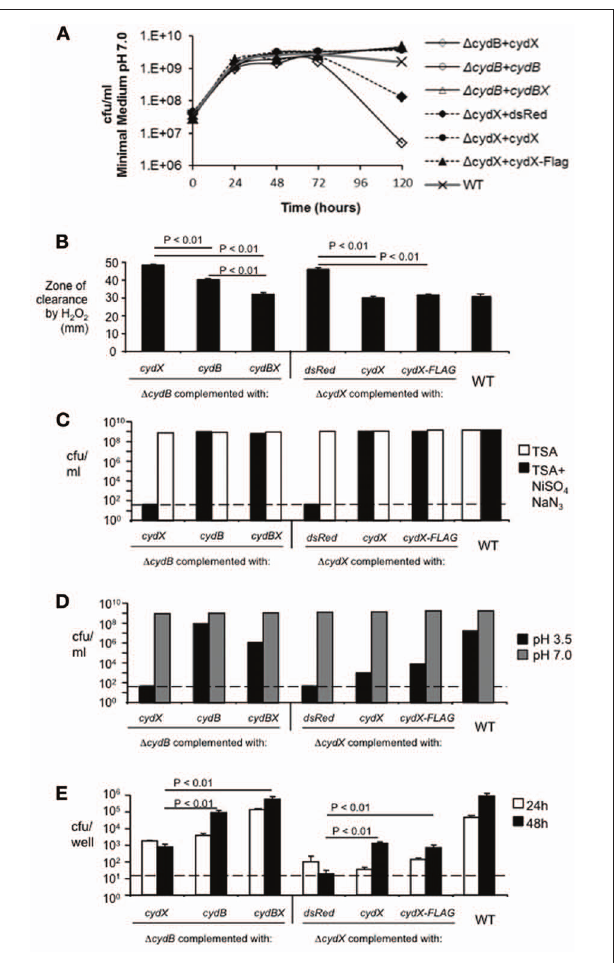
FIGURE 3 | Complementation of cydX mutation. Plasmid-encoded copies of cydB or cydBX , cydX or cydX-FLAG were introduced into cydX and cydB mutants. A plasmid expressing DsRed served as a negative control. (A) Restoration of stationary phase viability was determined as decribed in Figure 2 . (B) Sensitivity to 3% Hydrogen peroxide was assayed as described in Figure 2 . Significance of differences was analyzed by One-Way ANOVA, with P values for pairwise comparisons with P < 0 . 05 indicated. (C) Sensitivity to sodium azide plus nickel sulfate was assayed as described in Figure 2 . (D) Sensitivity to acid pH. Viability of cultures incubated for 5h in E-medium adjusted to pH 7.0 or pH 3.5 was assayed as described in the Materials and Methods. Each data point represents results of a single assay that was repeated twice. (E) Survival in J774 mouse macrophages. J774 cells were infected with cydX or cydB mutants containing indicated plasmids. Cells were lysed at 24 and 48h post-infection. Bacterial CFU were determined by serial dilution and plating on TSA. Data represent the mean of triplicate samples ± SD from a single experiment of three replicates with similar results. Significance of differences was analyzed by One-Way ANOVA, with P values for pairwise comparisons with P < 0 . 05 indicated. Dotted lines indicate the limit of